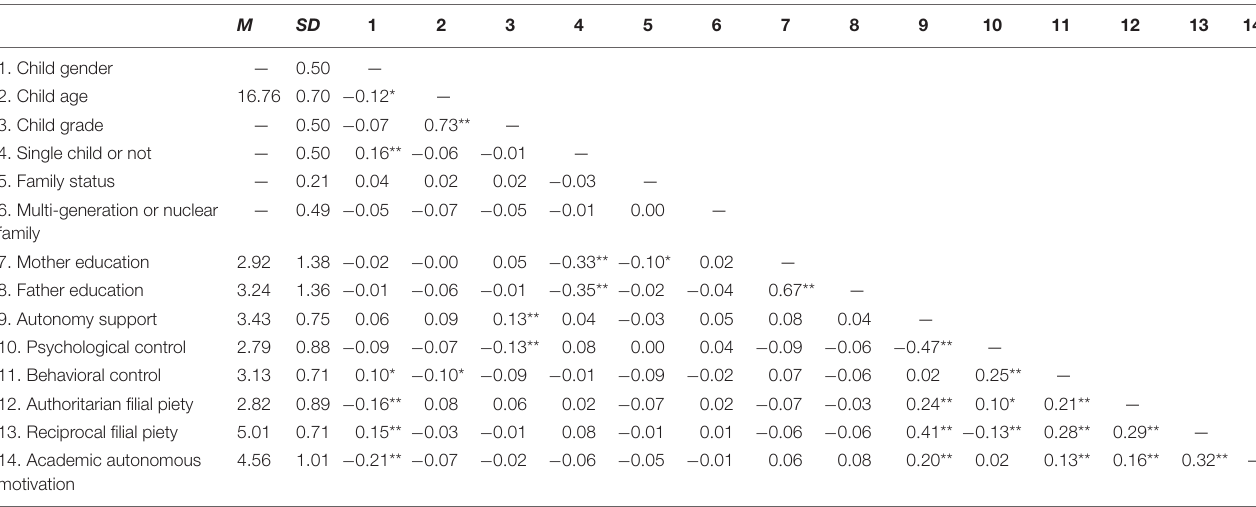
TABLE 2 | Correlations, means and standard deviations of the study variables.